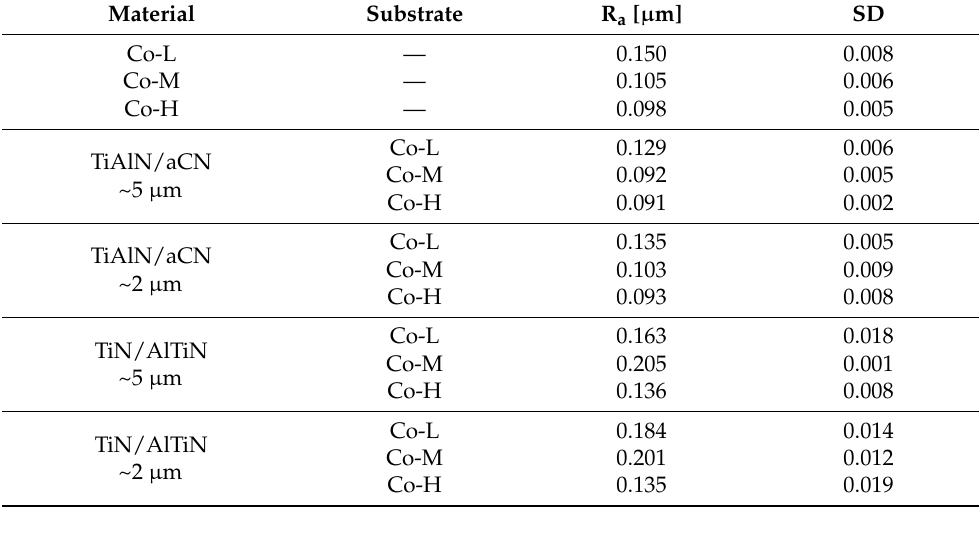
Table 3. Surface roughness of substrates, TiN/AlTiN and TiAlN/a-C:N coatings.